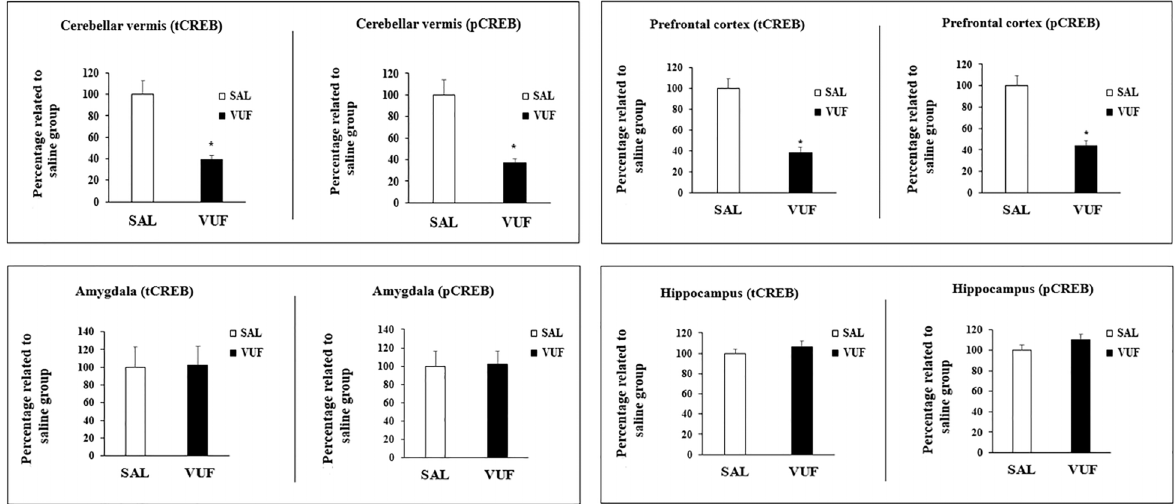
Figure 2. Percentages of total CREB (tCREB) and phosphorylated CREB (pCREB) of the 500 ng/kg VUF-8430-treated group (VUF) compared to the 9% saline control group (SAL) in the following structures: cerebellar vermis, prefrontal cortex, amygdala, and hippocampus. Data in the histograms are reported as the means ± SE (n=5 mice/group). *P o 0.05, Student ’ s t